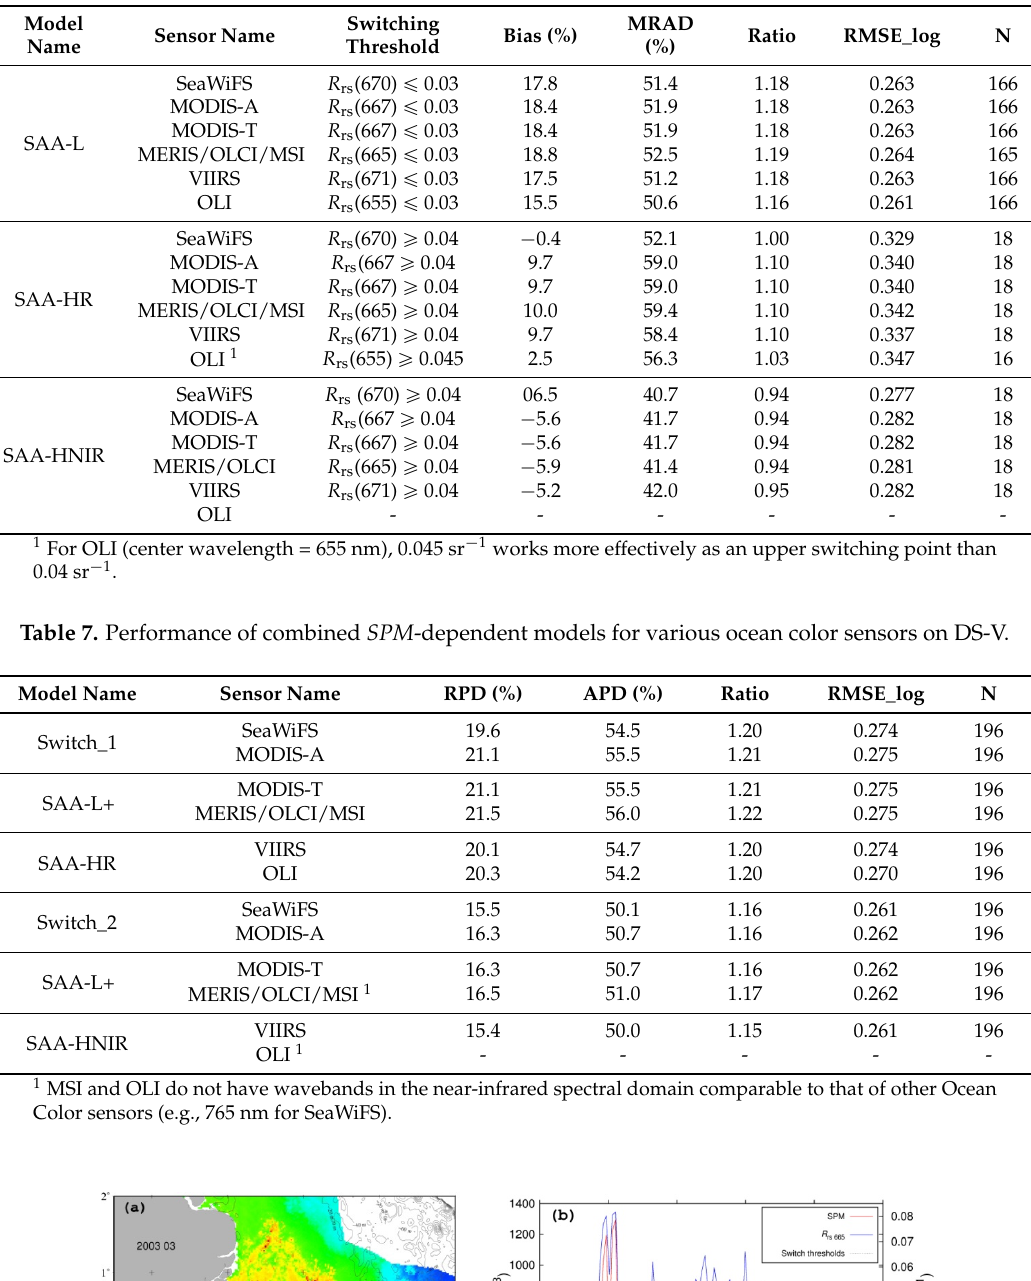
Table 6. Validation of SPM-dependent models on DS-V.